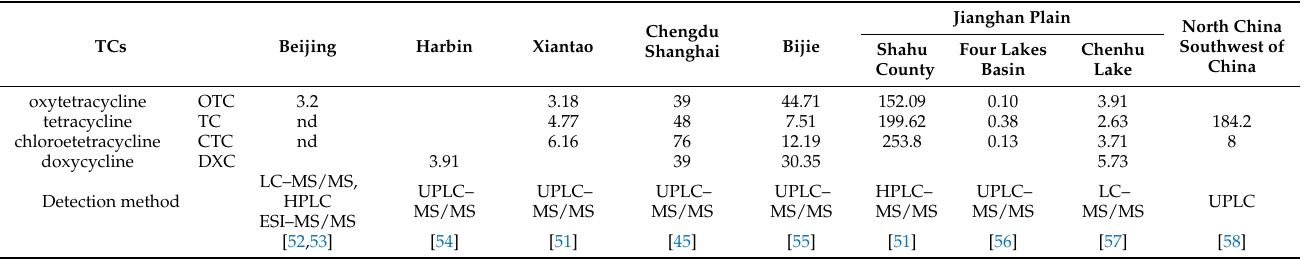
Table 1. TCs and their concentrations detected in groundwater of China (ng/L), and the detection